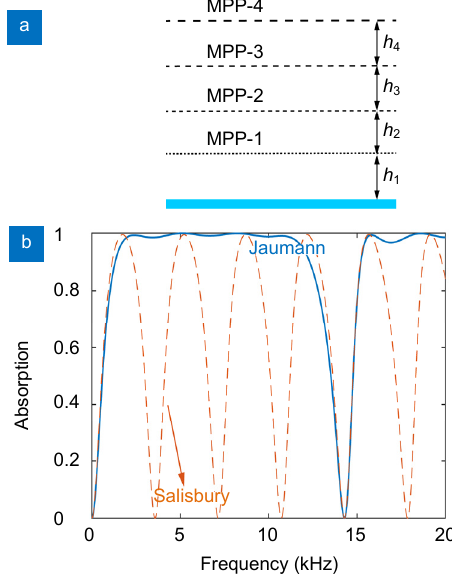
Fig. 4 | Acoustic Salisbury and Jaumann absorbers. ( a ) Schematic of the configuration of the multilayered acoustic absorbers. ( b ) Absorption spectra of the acoustic Salisbury and Jaumann